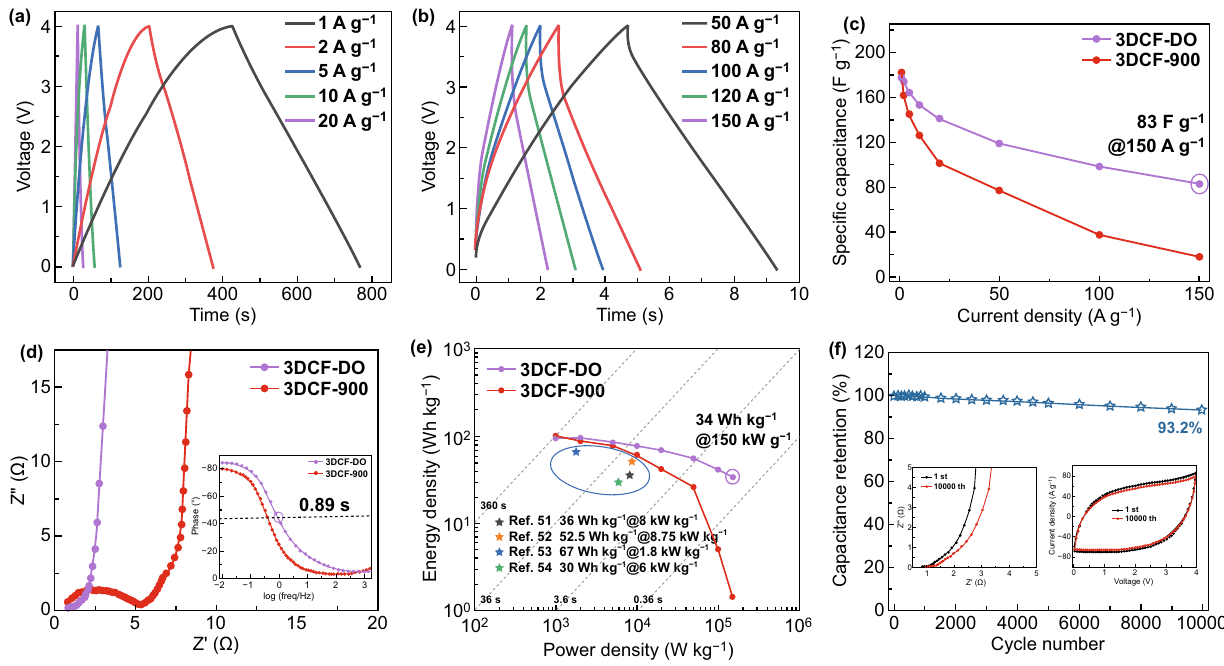
Fig. 4 Electrochemical performance of 3DCF-900 and 3DCF-DO as electrodes of symmetric two-electrode coin cells in EMIMBF4 electrolyte at 4 V; a GCD curves of 3DCF-DO at current density from 1 to 20 A g −1 ; b GCD curves of 3DCF-DO at current density from 50 to 150 A g −1 ; c Rate performance, d Nyquist plots (inset is the Bode plots). e Ragone plots of 3DCF-900 and 3DCF-DO. f Stability test conducted at 1 V s −1 for 10,000 cycles in EMIMBF4 at 4